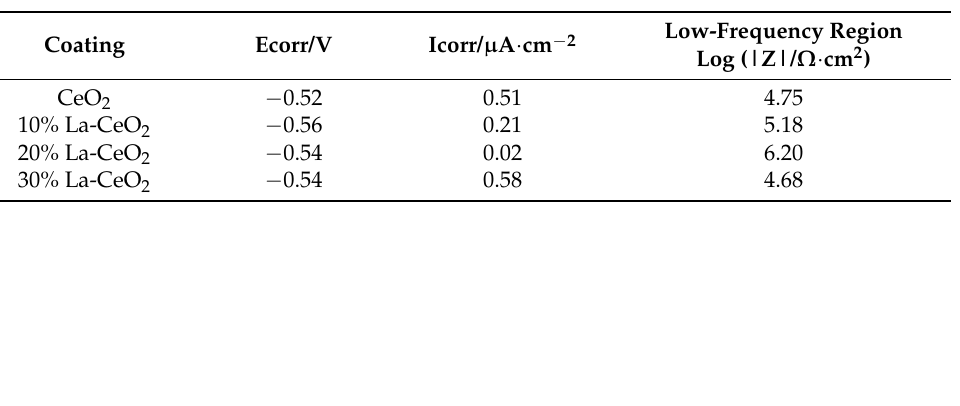
Table 2. Electrochemical data of La-doped CeO 2 coating after UV irradiation for 12